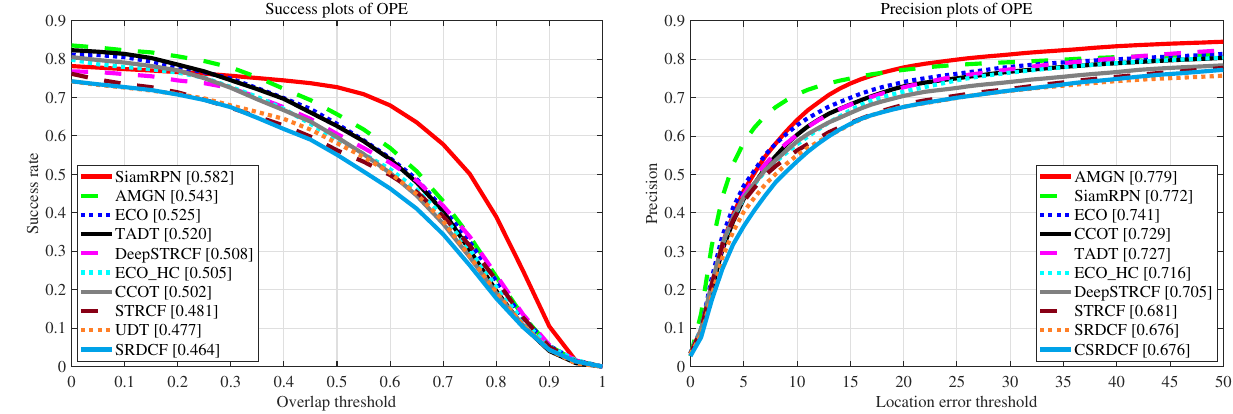
Figure 5. Success and precision plots on the UAV123 dataset using one-pass